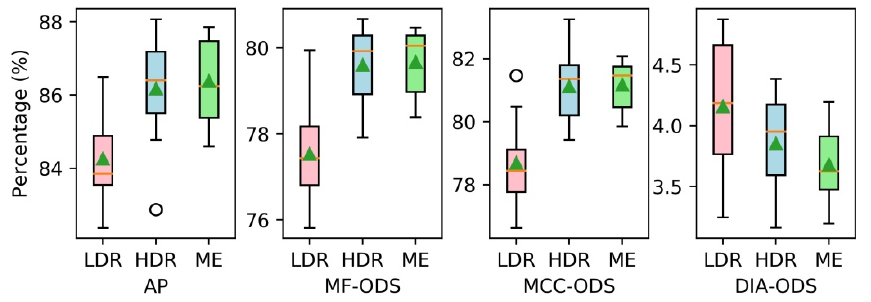
Figure 8. The performances of FCN models with different inputs. Table 2. The mean values of evaluation metrics computed from FCN models with different inputs. Models